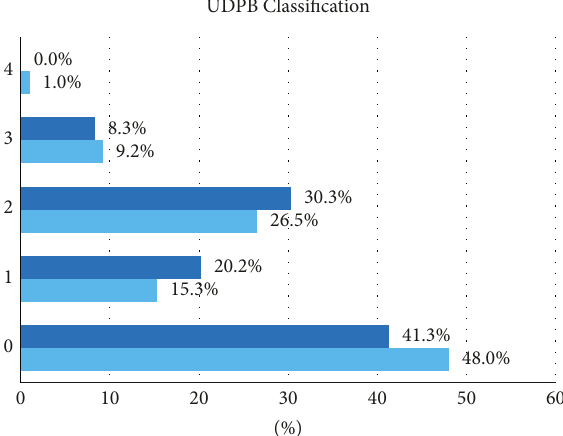
Figure 1: Perioperative universal definition of perioperative bleeding (UDPB) classification ( ( f ) : fisher’s exact test, ( x ) : χ 2